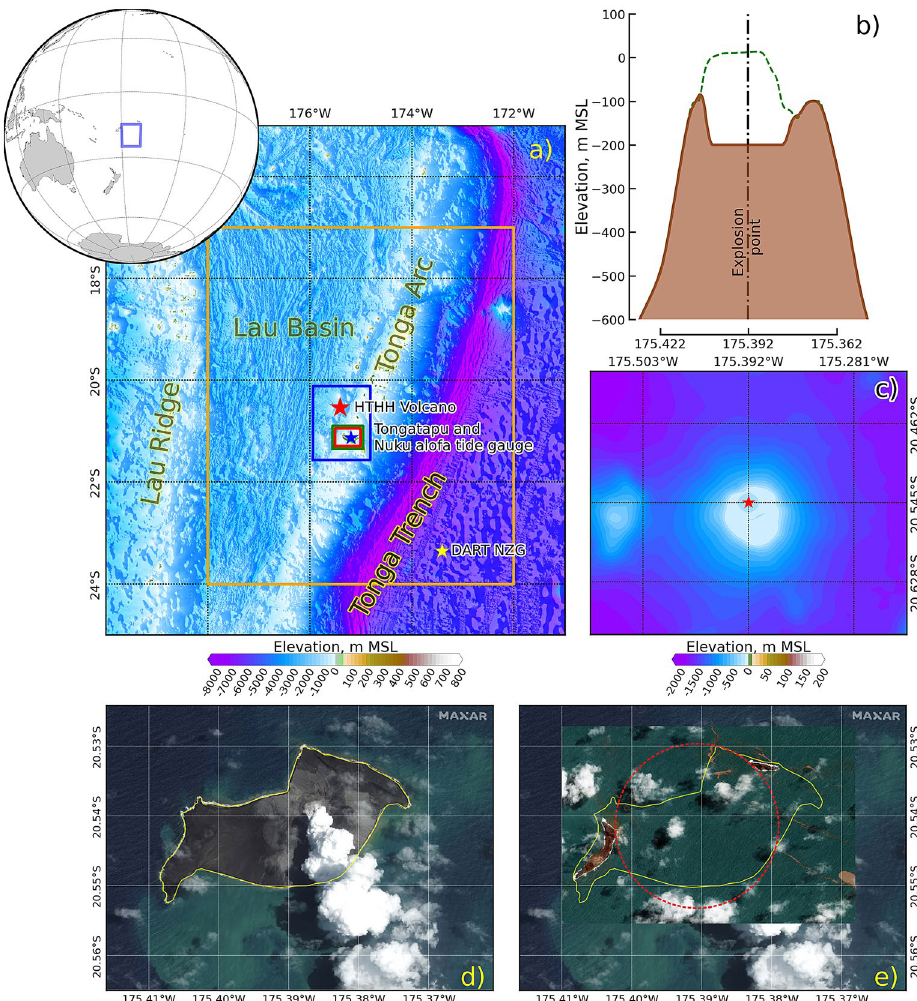
Figure 1. Study area. ( a ) Location of the Hunga Tonga-Hunga Ha’apai (HTHH) volcano (red star); Tonga’s Tongatapu and the selected observation point on the tide gauge (Nuku’alofa) are represented by the blue star, the yellow star is the selected observation point on the New Zealand DART station (NZG), and the 4 colored boxes (orange, blue, green, and red) are the areas used to simulate the tsunami, based on 60, 15, 3, and 1 arcsecond, ◦ respectively. ( b ) The profile of HTHH volcano (at 20.545 S) before (green dashed line) and after (brown line) the eruption. ( c ) Topographic data (1 arcsecond) around HTHH volcano showing that the subduction area around the center of the eruption (red star) was hypothesized by the satellite image between ( d , e ). ( d ) Satellite image of the HTHH volcano before the eruption on 6 January 2022 by MAXAR, where the yellow line is the shoreline of the volcanic island. ( e ) Satellite image of the HTHH volcano after the eruption on 18 January 2022, for which the red dashed cycle was hypothesized to be the subduction area of this event. The satellite image from 2022 MAXAR Technologies were downloaded from ALASKA PUBLIC MEDIA 5 website (https:// www. alask apubl ic. org/ 2022/ 01/ 18/ nasa- scien tists- estim ate- tonga- blast- at- 10- megat ons). The figure was generated by using a QGIS software 11 , version 3.16.15-Hannover (http:// www. qgis.